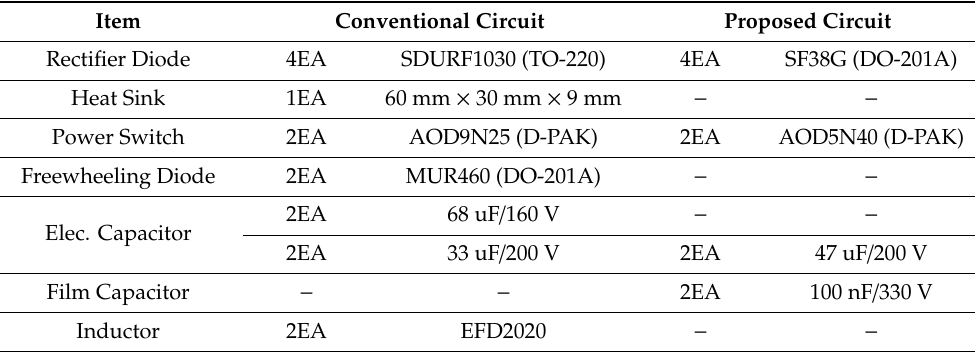
Table 2. Comparisons between conventional and proposed converters (2CH).